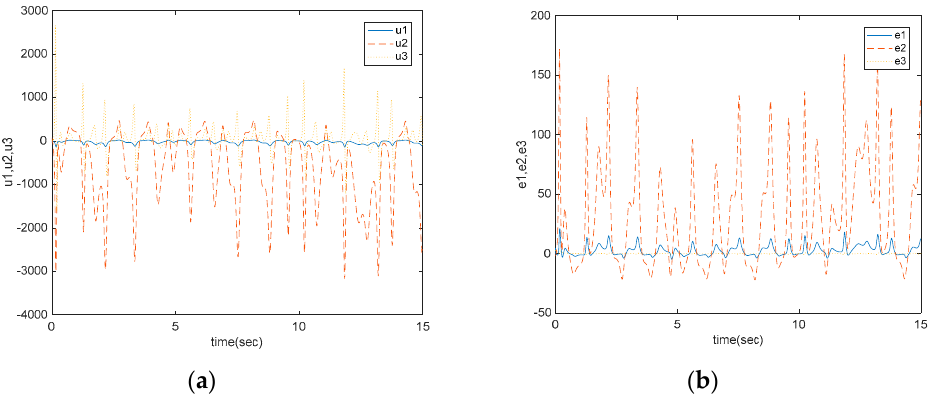
Figure 16. Control input and error diagram. ( a ) Control input diagram; ( b ) Error diagram.